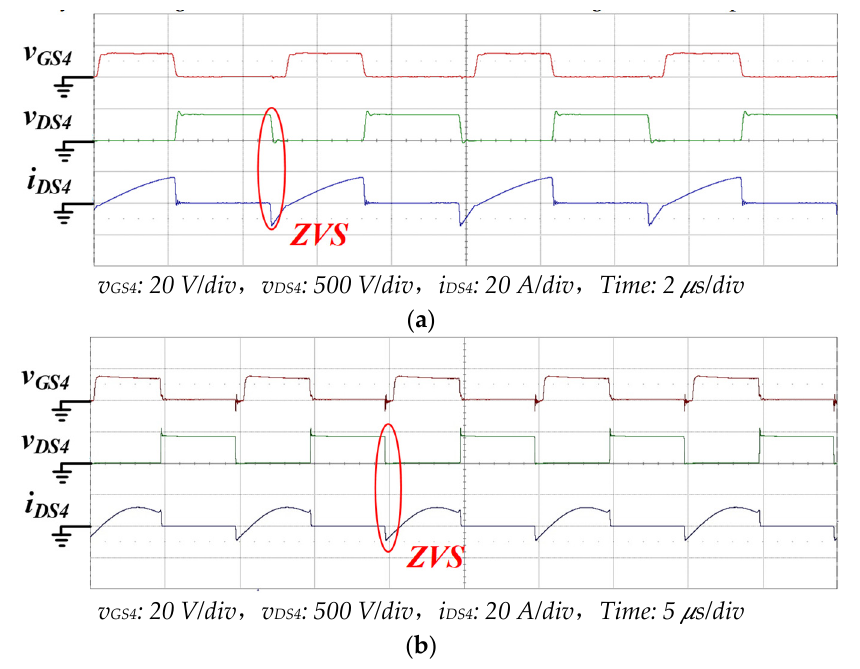
Figure 17. The v GS4 , v DS4 , and i DS4 waveforms in G2V mode. ( a ) V DC Grid = 400 V, V Vehicle_Bat = 280 V, I Vehicle_Bat = 7.5 A; ( b ) VDC Grid = 400 V, VVehicle_Bat = 403 V, IVehicle_Bat = 7.5 A.